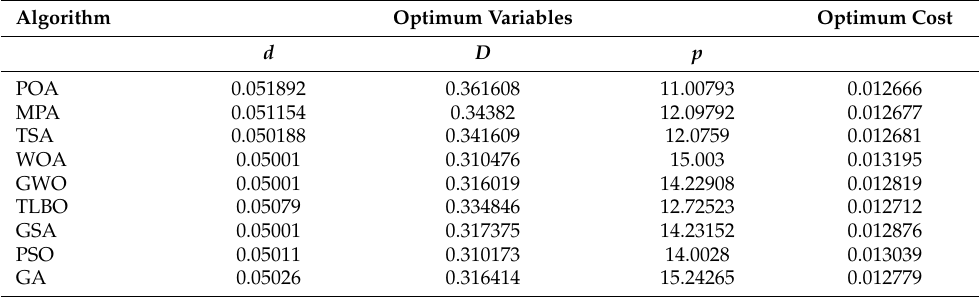
Table 15. Comparison results for tension/compression spring design problem.